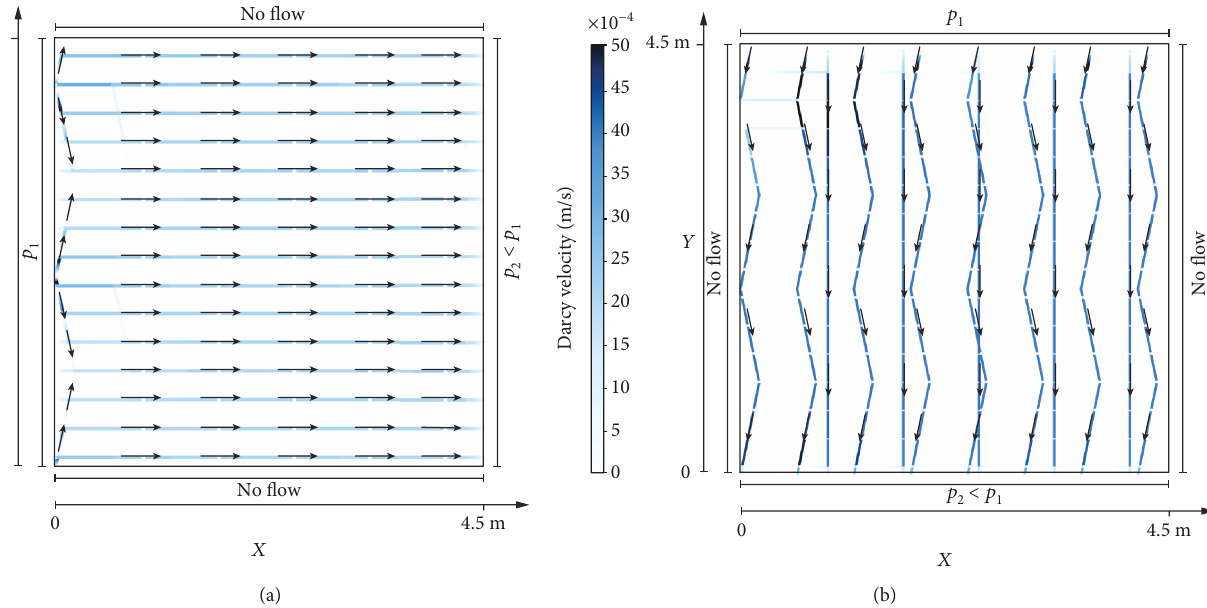
Figure 7: Example of results concerning the Darcy velocity fl ow (coloured lines) inside the 2D fractures along the x -direction (a) and y -direction (b) for the case with the minimum fracture aperture. The black arrows indicate the fl ow direction inside the